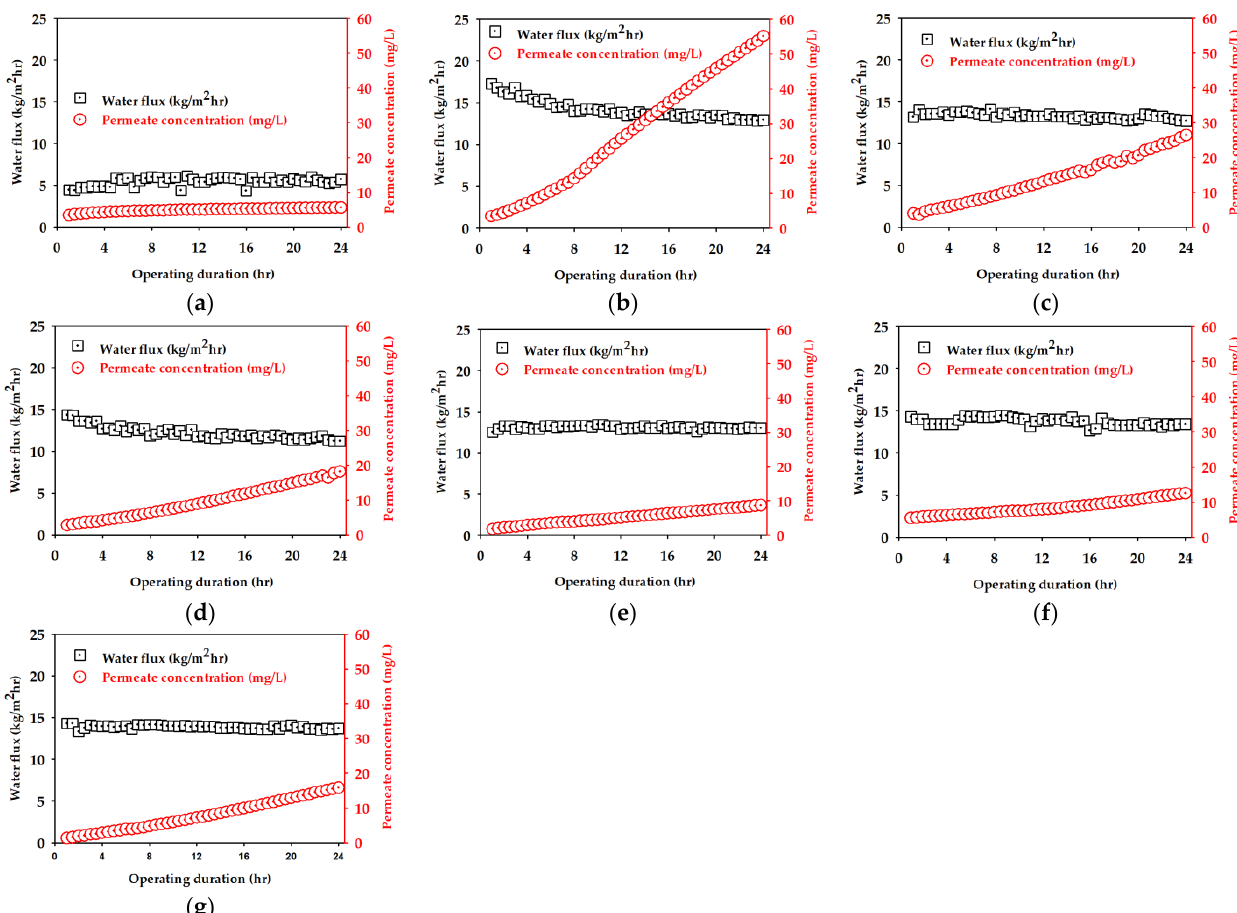
Figure 7. Water flux and salt permeate concentration for 24 h operation by DCMD on 35 g/L NaCl solution: ( a ) (S1) PVDF 14 wt.% with water, ( b ) (S2) PVDF 14 wt.% + LiCl with water, ( c ) (S3) PVDF 16 wt.% + LiCl with water, ( d ) (S4) PVDF 18 wt.% + LiCl with water, ( e ) (S5) PVDF 16 wt.% + LiCl with water (90%) + EtOH (10%), ( f ) (S6) PVDF 16 wt.% + LiCl with water (80%) + EtOH (20%), and ( g ) (S7) PVDF 16 wt.% + LiCl with water (70%) + EtOH (30%). For all DCMD experiments, the feed and distillate temperatures were 60 and 20 °C, respectively. Table 3. Average water flux and apparent rejection for 24 h operation by DCMD on 35 g/L NaCl